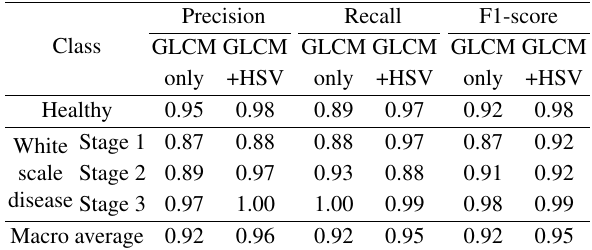
classification on GLCM only and GLCM+HSV features.